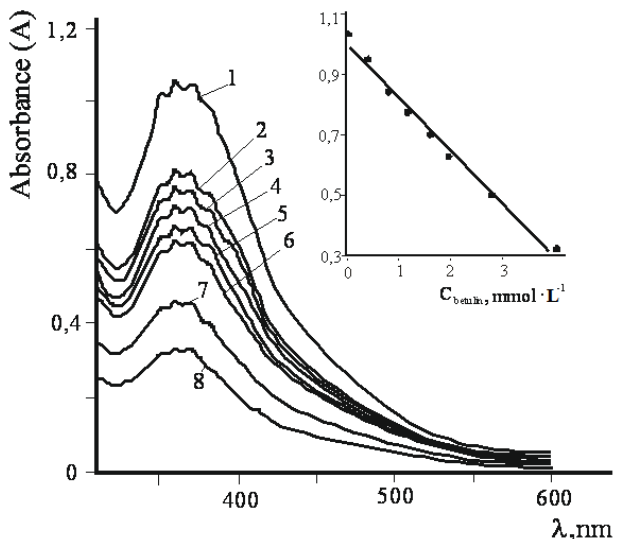
Figure 6. UV-visible spectra of reaction mixtures; C = const = 0.27 mmol·L − 1 . Initial concentration of betulin corresponds to N curves C Al 2 (SO 4 ) 3 (mmol·L − 1 ) 1–0; 2–0.40; 3–0.80; 4–1.21; 5–1.61; 6–2.01; 7–2.82; 8–4.03. The inset figure is magnification for the absorbance A: A = f (c